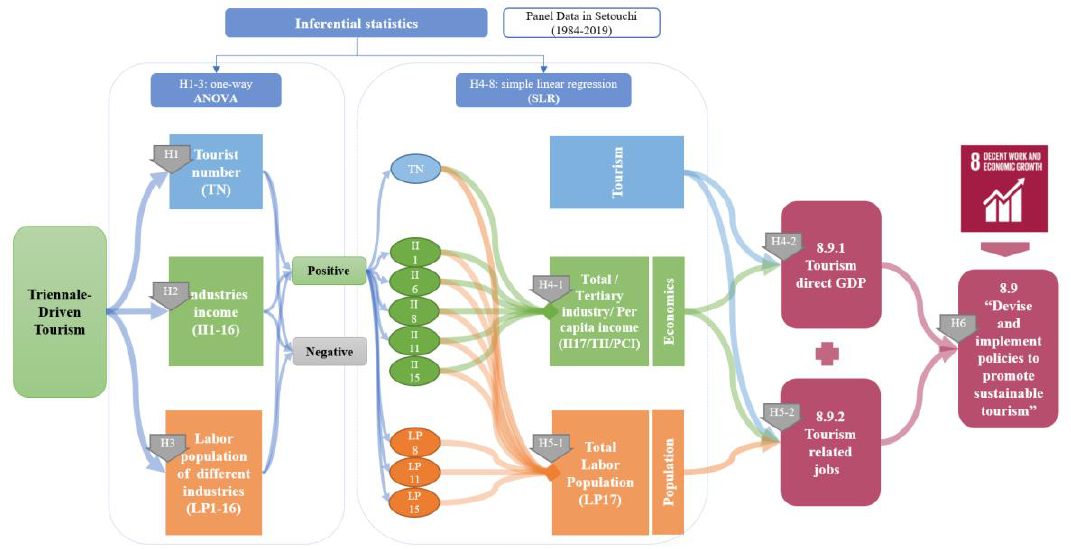
Figure 1. The logical model. Note: SLR = Simple Linear Regression; ANOVA =Analysis of variance; SDGs =Sustainable Development Goals.